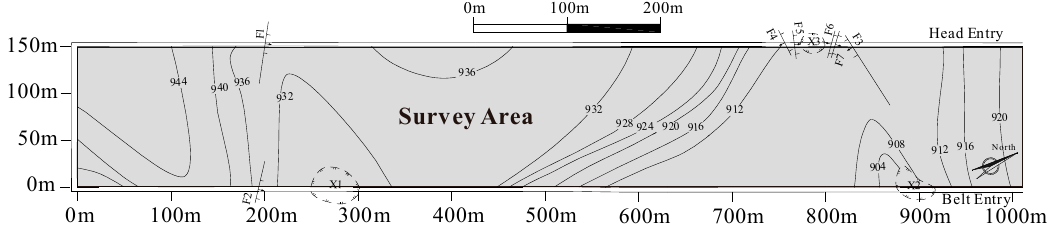
Figure 8. Geological map of the survey area. Table 1. Faults exposed in the detection area.